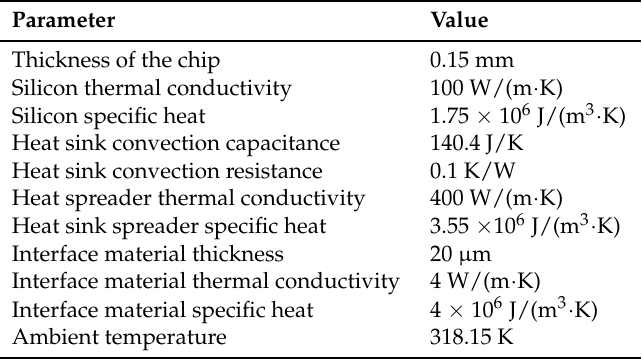
Table 4. Configuration parameters of HotSpot.